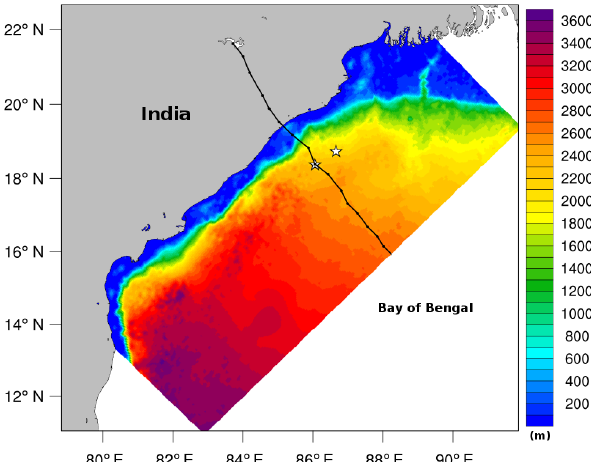
Figure 2. The COAWST model domain (65–105 ◦ E, 1–34 ◦ N) over- laid with ETOPO2 bathymetry (m). Locations used for time series analysis are marked with